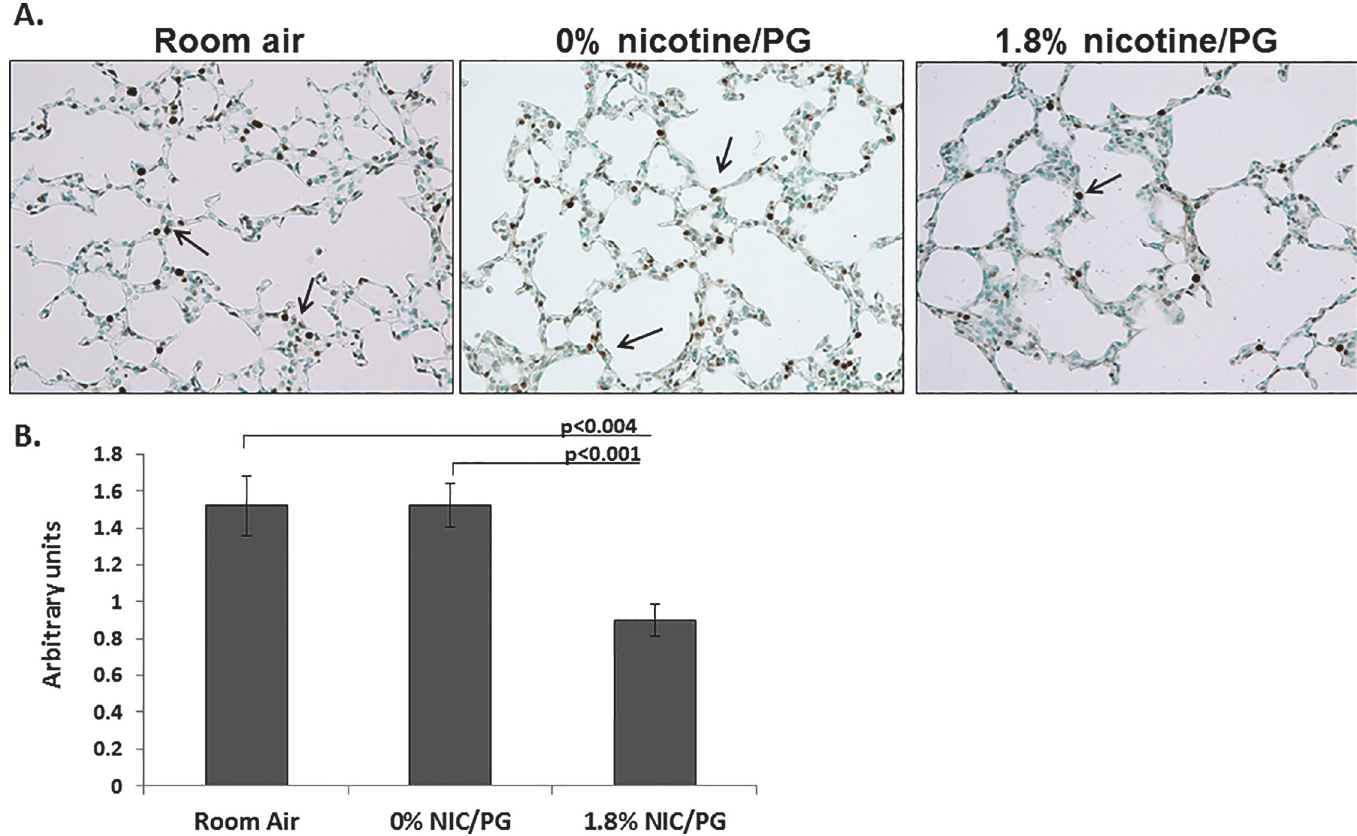
Fig 2. Decreased cell proliferation in airspaces of neonatal mice exposed to 1.8% nicotine/PG. A. Arrows point to KI67 staining in the airspaces of 10 day old neonatal mice. B. Quantification of KI67 staining showed significantly less KI67 staining in 10 day old neonatal mice chronically exposed to 1.8% nicotine/PG compared to room air and 0% nicotine/PG treated mice. (n = 8 per group, error bars reflect standard error of the mean).